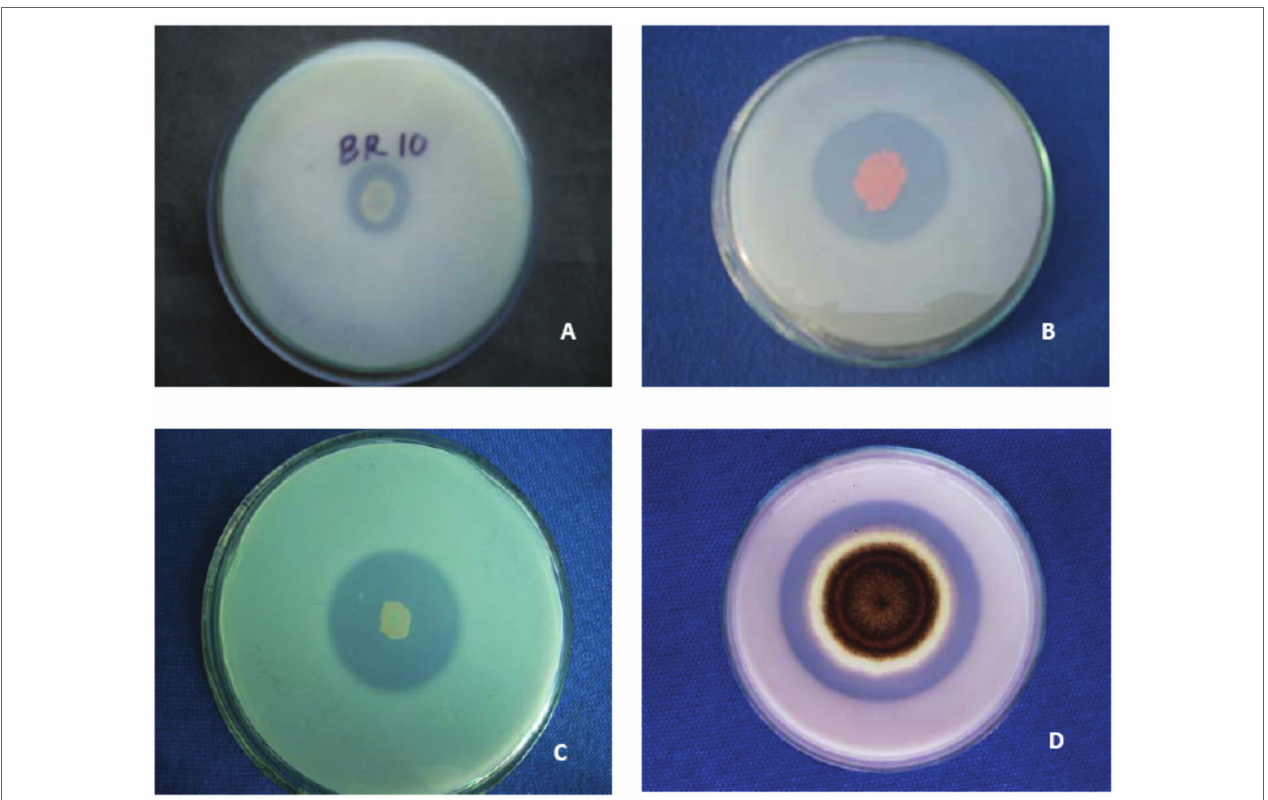
FIGURE 1 | Demonstration of solubilization of insoluble tri-calcium phosphate by species of- (A) Pseudomonas (B) Serratia (C) Bacillus and (D) Aspergillus on Pikovskaya (1948) medium.